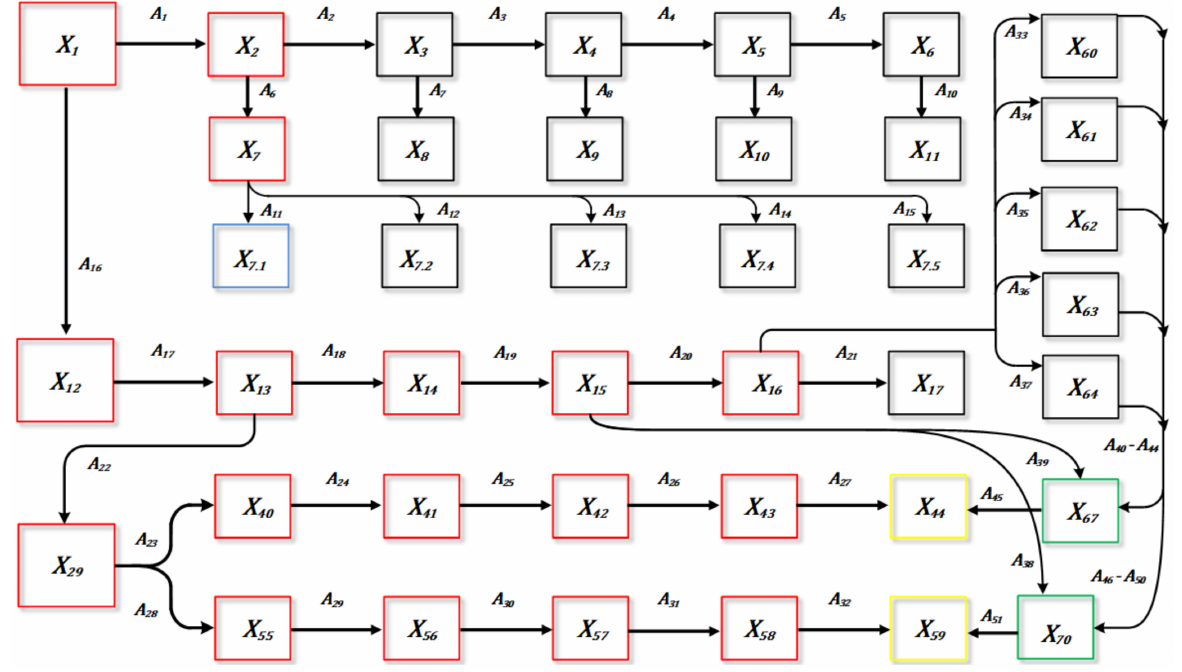
(cid:0) (cid:1) X (cid:48) , A (cid:48) to prevent